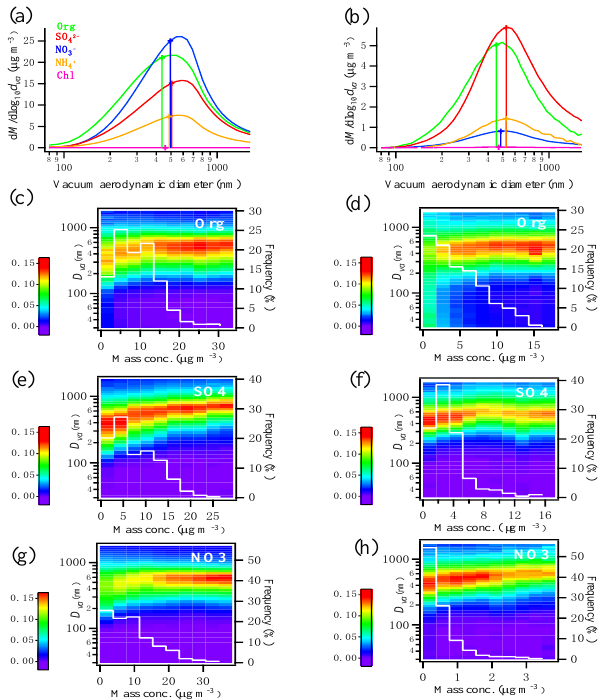
Figure 3. Average size distributions of AMS species, together with MMD (vacuum aerodynamic diameter) at (a) NCB and (b) SCB, as well as variation in normalized size distribution as a function of component mass concentration at (c, e, g) NCB and (d, f, h) SCB.